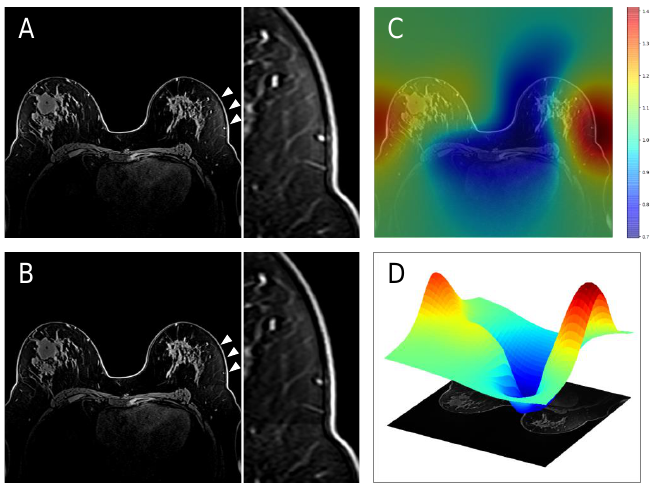
Figure 2. ( A ) Uncorrected pre-contrast image and the enlarged image, ( B ) Bias-corrected pre-contrast image and the enlarged image, ( C ) Overlay of the corresponding estimated bias field, ( D ) 3D surface plot of the estimated bias field on a single axial slice. The numbers (unitless) in the scale represent the distribution of pixel intensity mean and variance with respect to the measured tissue in the local region. Please note that ( C , D ) show the estimated bias field for the whole image. In this study, bias-correction was performed only within the whole breast mask. Arrowheads and the enlarged images highlight the area with significant field inhomogeneity in the contralateral